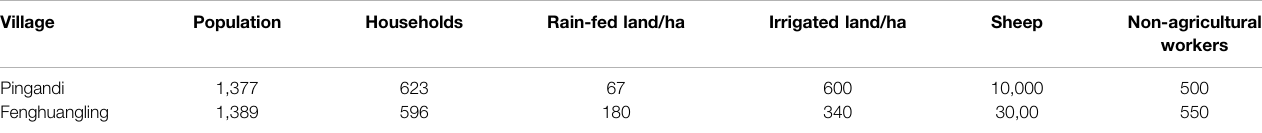
TABLE 1 | The socioeconomic status of farmer villages in 2016.